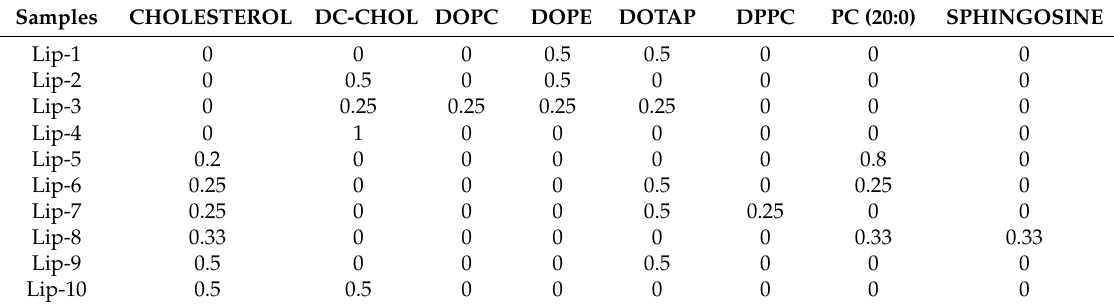
Table 1. The molar ratios of lipids used for synthesized a library of 10 liposomal formulations. Samples CHOLESTEROL